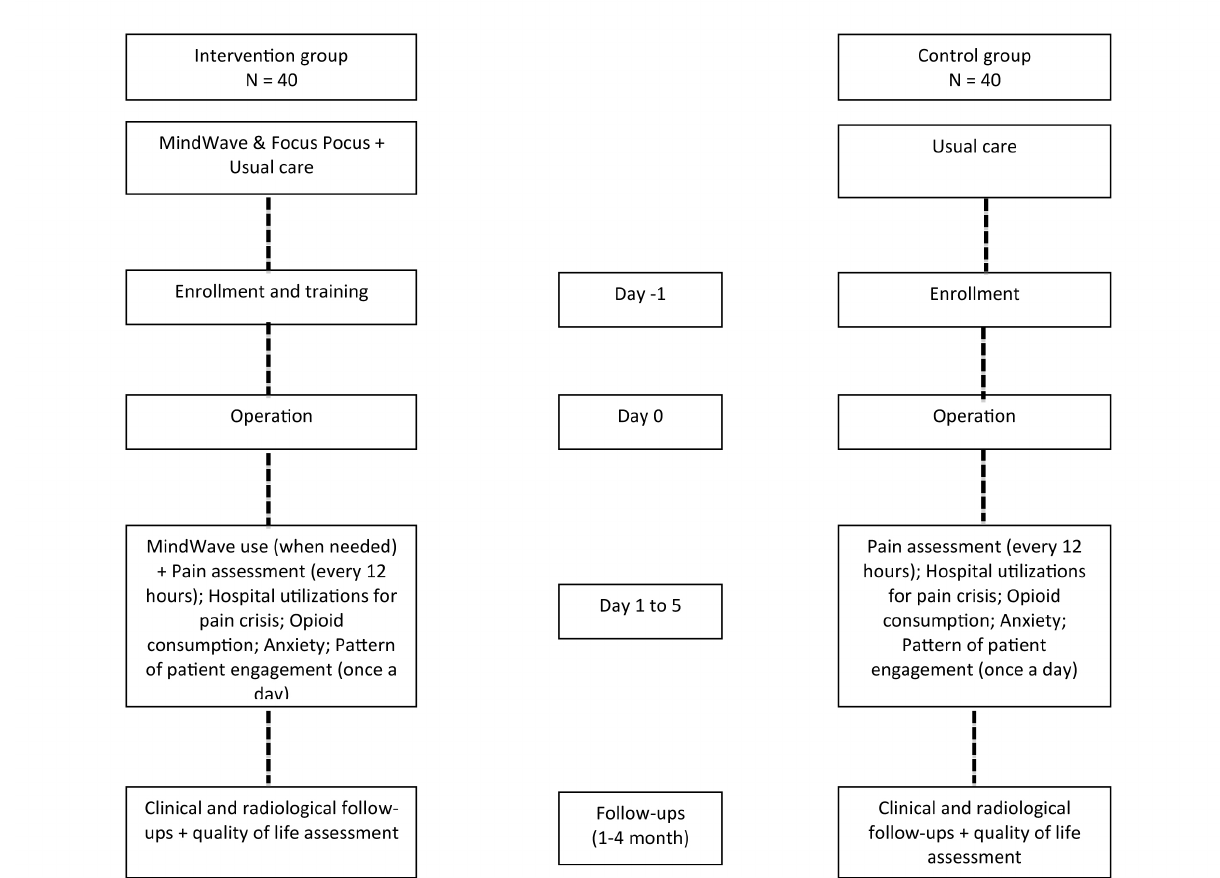
Figure 1. Schematic representation of the trial